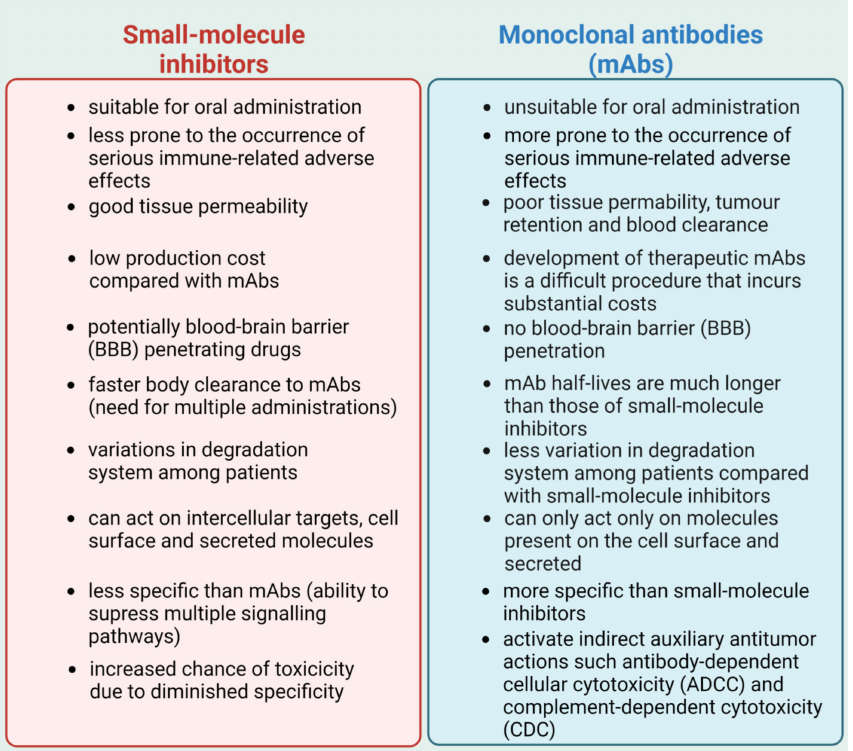
Figure 4. Comparison of small-molecule inhibitors and monoclonal antibodies (mAbs). Based on [202]. Created with BioRender.com accessed on 1 February